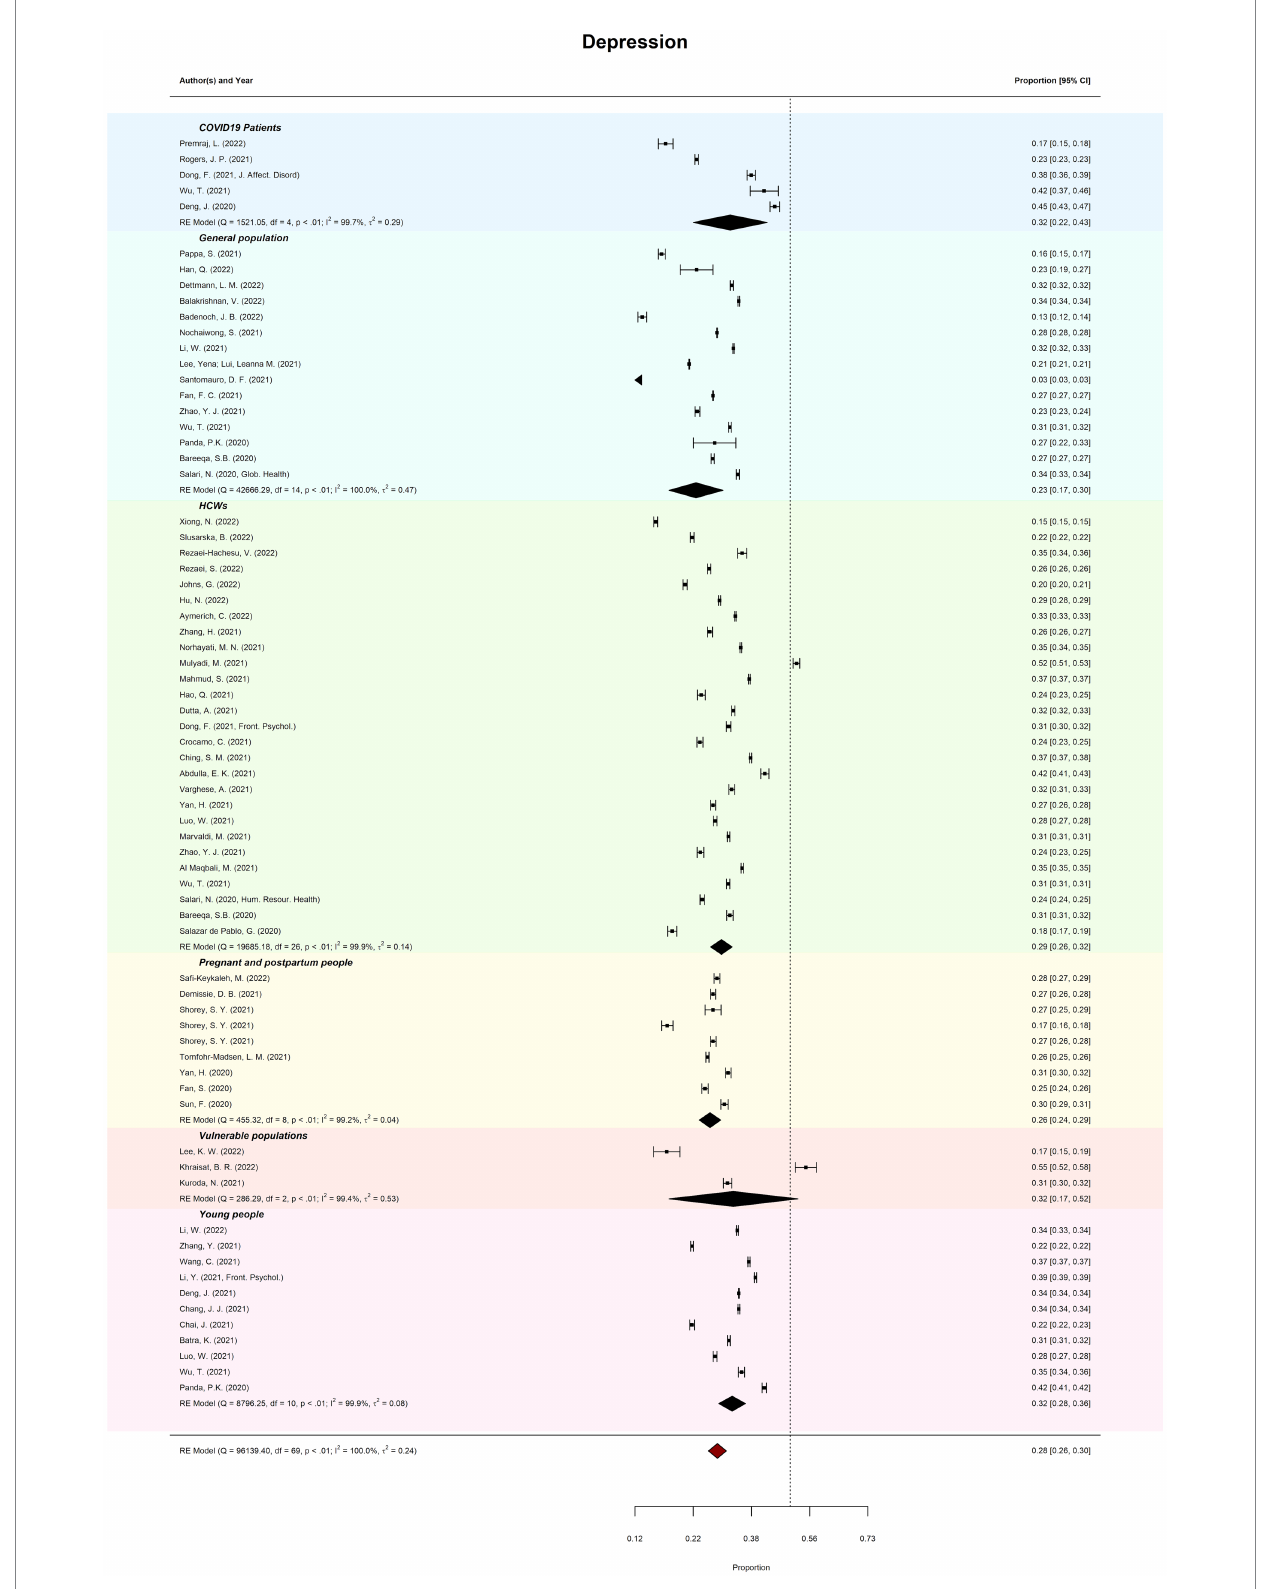
FIGURE 2 Meta-review of pooled prevalence of depression. Displays the forest plots of probable depression prevalence (and 95% CIs) across all